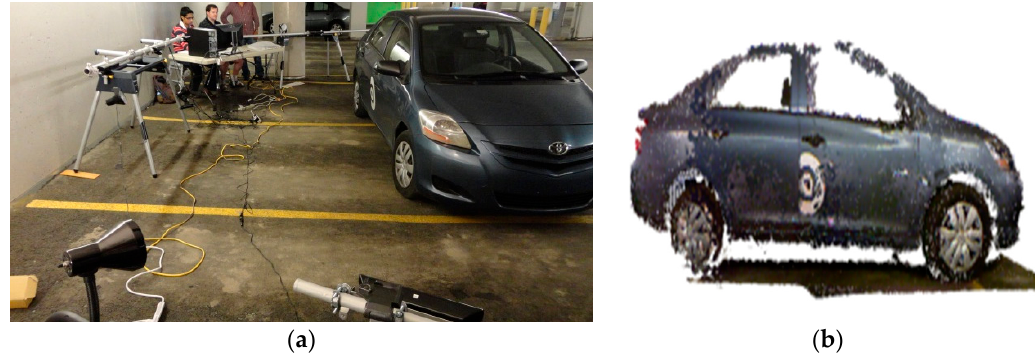
Figure 2. Inspection system prototype with: ( a ) network of Kinect sensors acquiring a rough model of the entire length of vehicle; and ( b ) approximate 3D model of vehicle’s lateral body panels.